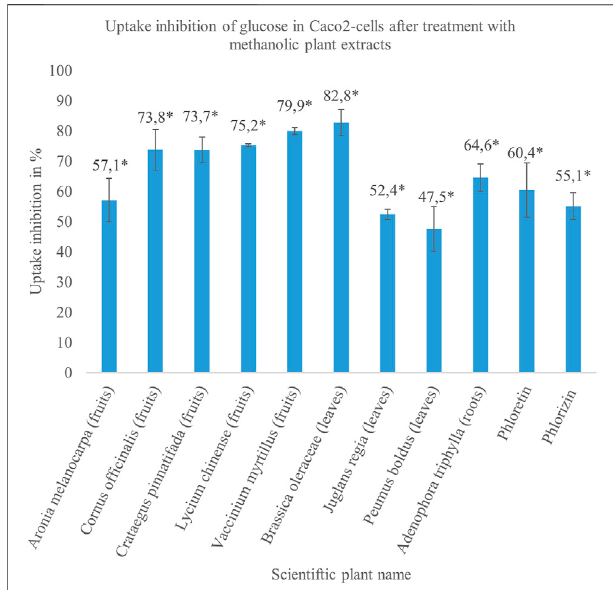
FIGURE 1 | The results of the methanolic plant extracts, which reduced glucoseuptakebetween40and80%intreatedcellssigni fi cantlycomparedto untreated cells in a concentration of 1 mg/ml. The extracts were made from different parts of the plants enclosed in brackets. The solutions of 100 µM phloretin and 100 µM phlorizin were used as positive controls and inhibited glucose uptake in Caco2 cells by approximately 60%. The illustrated results referto thedata in Table 2 . Mean value ± SD. * Signi fi cantdifferencein U -test ( n (cid:1) 2 with 12 replicates each; two-sided, α (cid:1) 0.05).